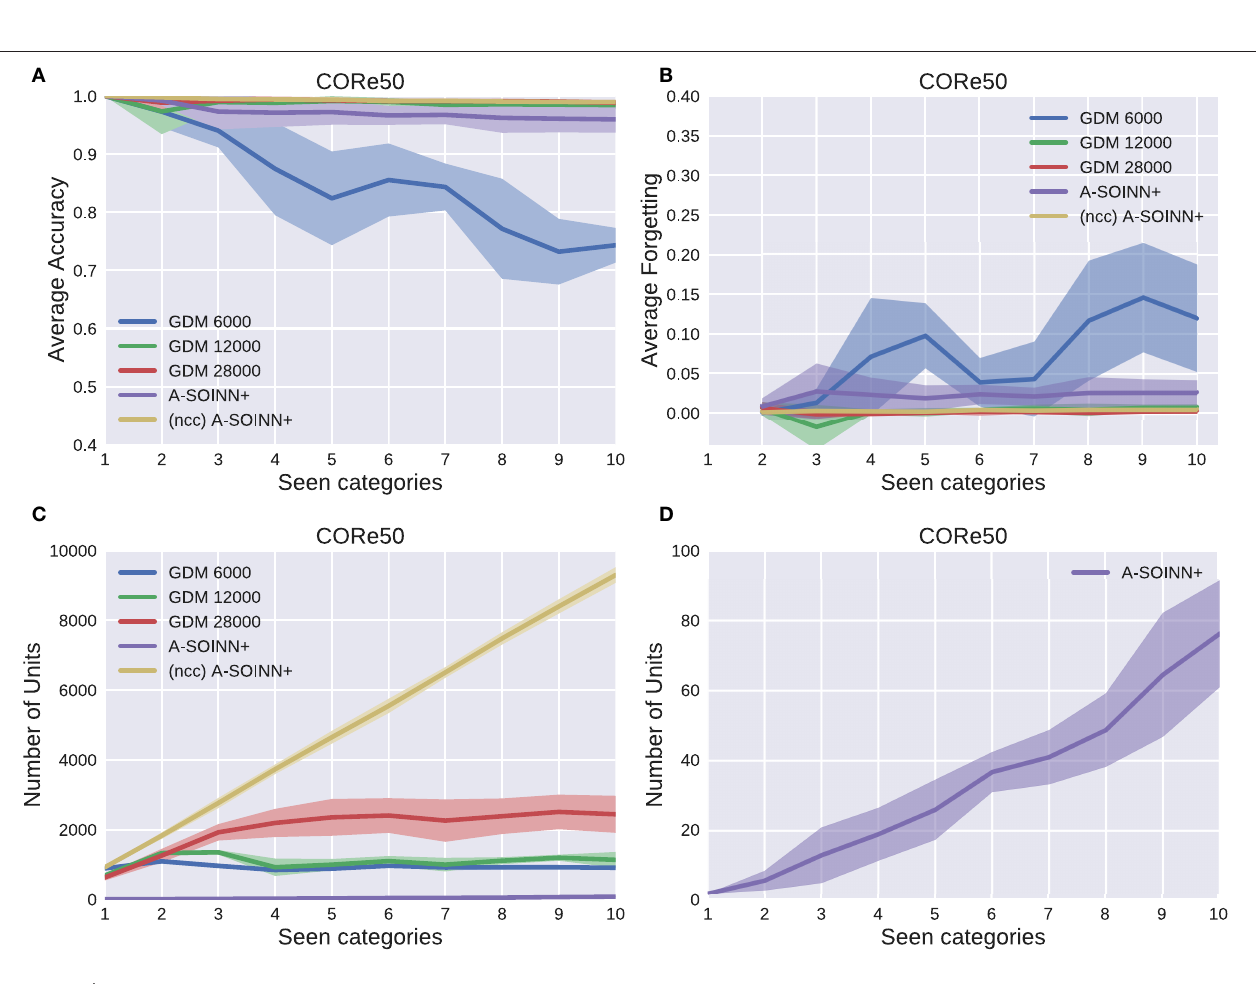
TABLE 5 | This table shows the arithmetic mean of the average accuracies across all 10 tasks (in percent) for each model (columns) in each experiment (rows). Dataset GDM 6,000